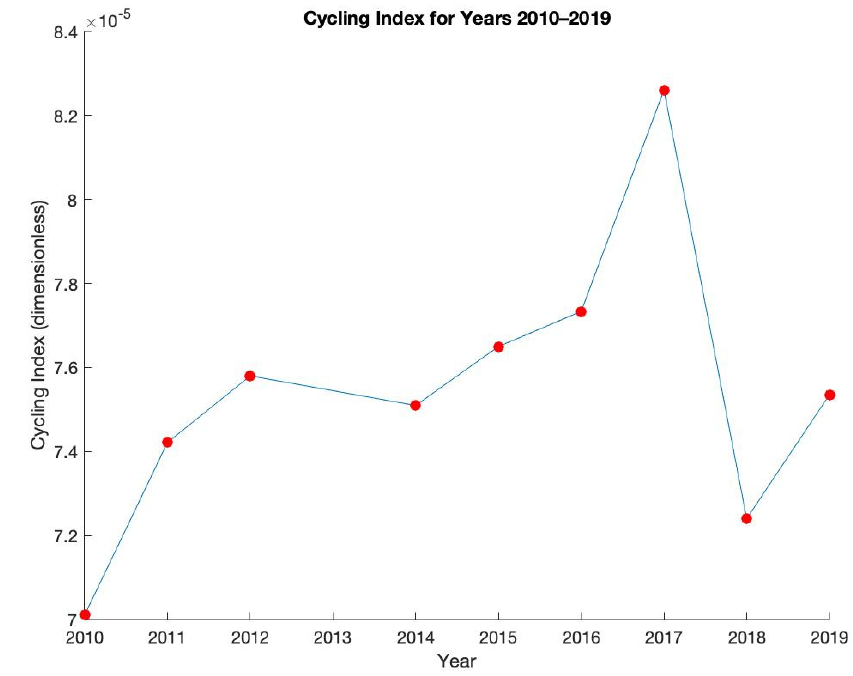
Figure 6. Cycling indices for Maryland’s energy industry from 2010–2019.